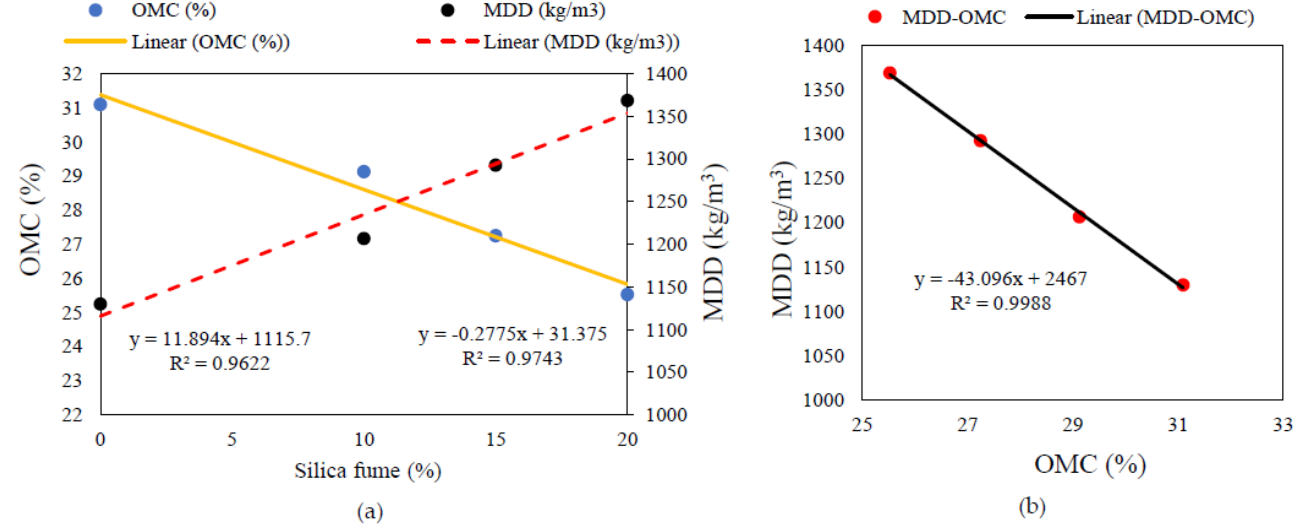
Figure 13. Statistical correlation among the peat compaction parameters: ( a ) variation of OMC and MDD with SF content and ( b ) variation of MDD with the OMC of SF-stabilized peat.